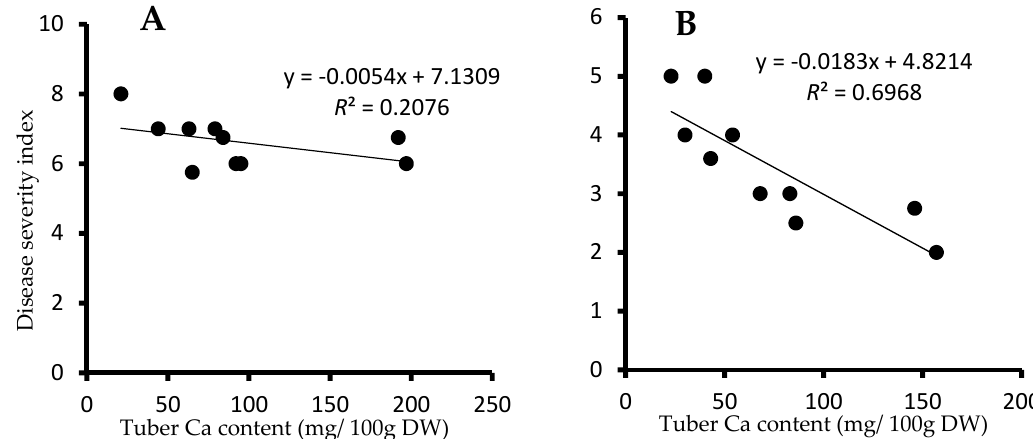
Figure 4. Correlation between late blight disease severity index and tuber calcium content in the Shenkola ( A ) and Gera ( B ) potato varieties.